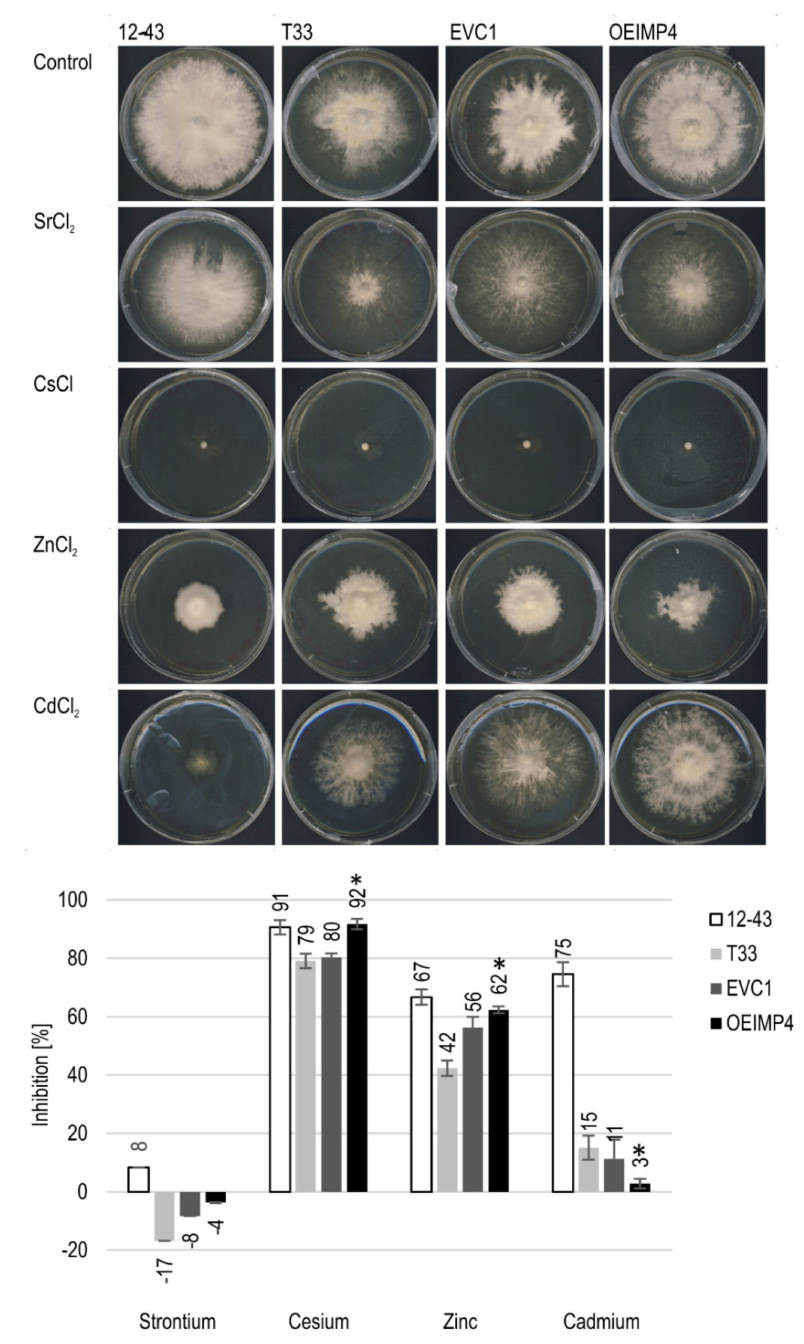
Figure 3. Growth inhibition of metals. Growth morphology ( top ) and inhibition calculated from mycelia diameter ( bottom ) of S. commune 12-43, T33, EVC1 and OEIMP4 in three biological